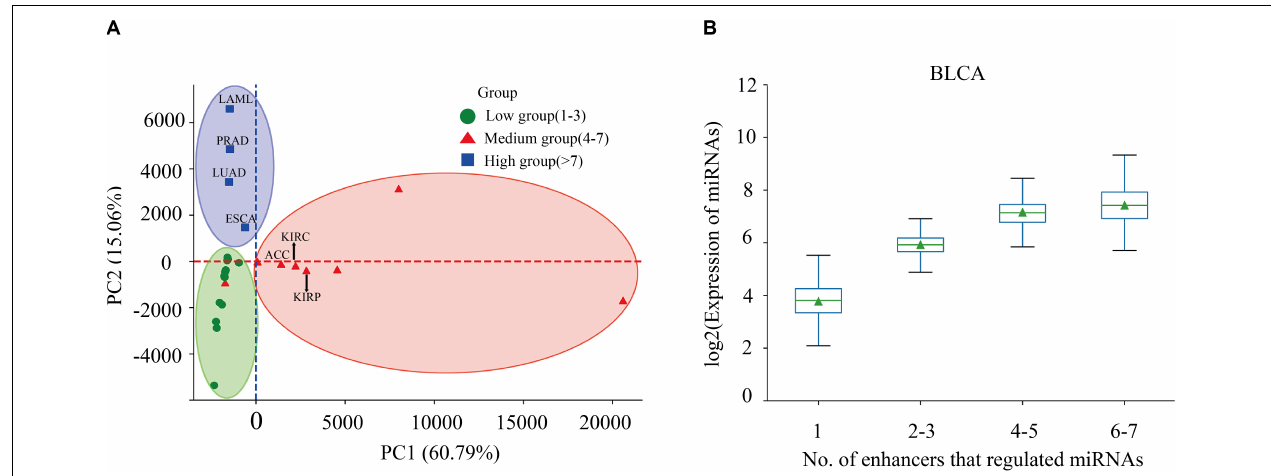
FIGURE 2 | Correlation between miRNA expression and the number of regulating enhancers. (A) Principal component analysis (PCA) of the expression levels of miRNAs regulated by enhancers in 31 cancers. (B) Expressions of miRNAs that are regulated by different numbers of enhancers in bladder urothelial carcinoma ( BLCA